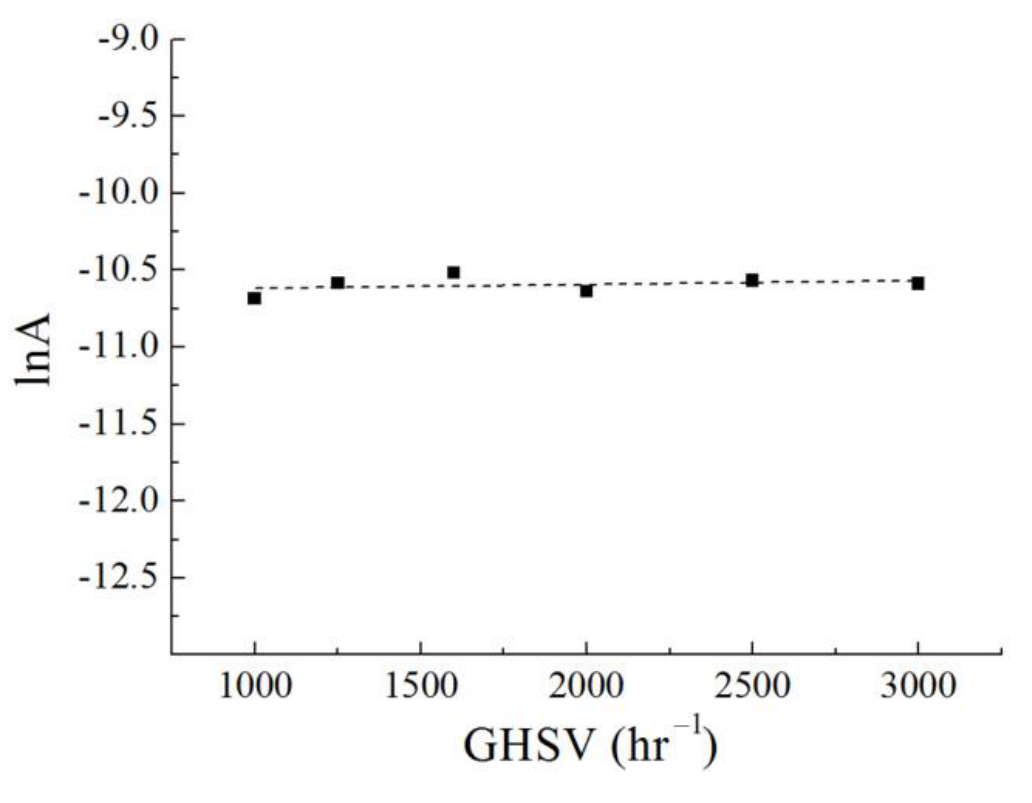
9 Table 3. Composition of C 5+ hydrocarbons, obtained over S2 and B. Catalyst